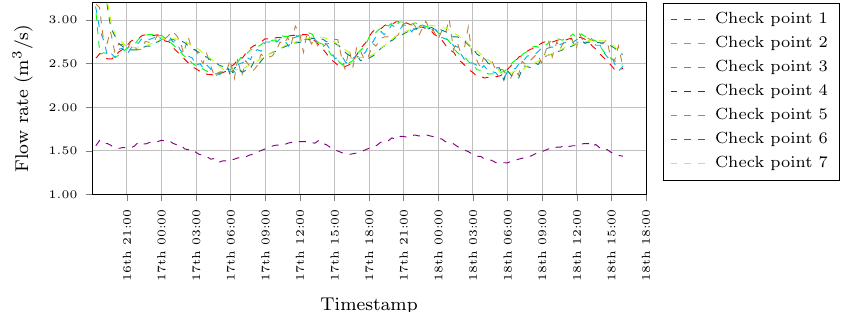
Figure 9. Flow time series graphs (June 2018).